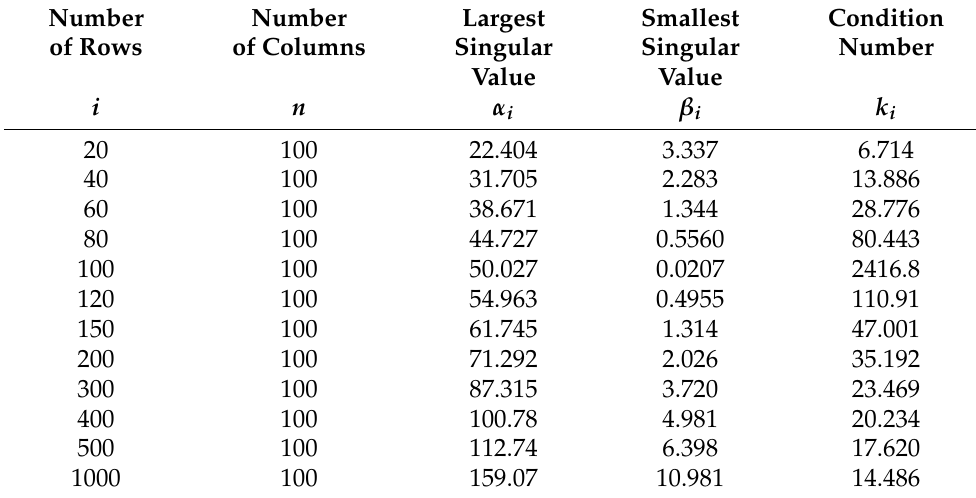
Table 8. The anomaly in random “0 or 1” matrix.